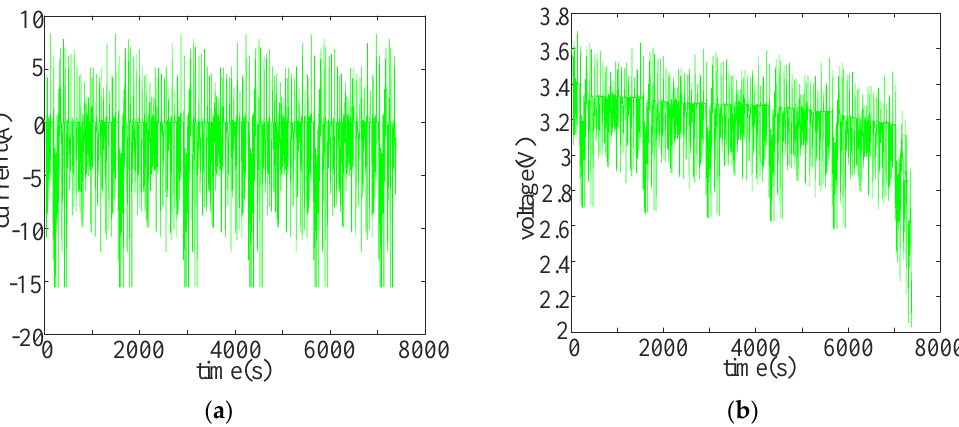
Figure 18. ( a ) Current curve at FUDS (federal urban driving schedule); ( b ) The measurement voltage.